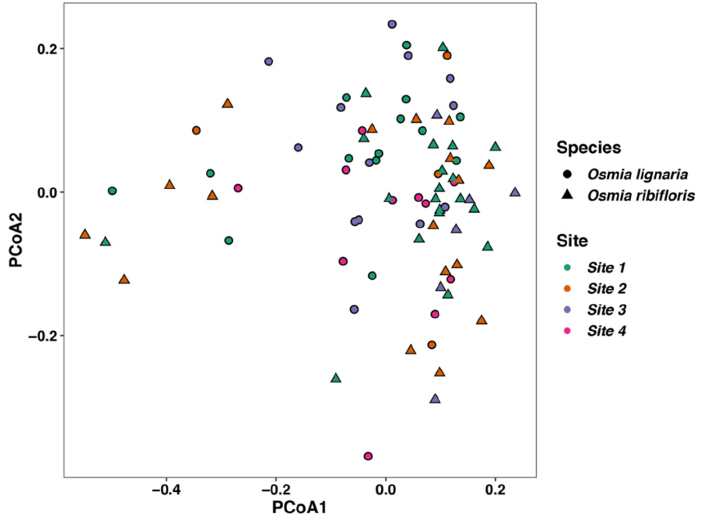
Figure 5. Principal components analysis (PCoA) ordination of the weighted UniFrac distances of microbial communities of both bee species ( Osmia lignaria and Osmia ribifloris ) and sampling site. There was a significant difference in the weighted UniFrac distances between bee species (F = 3.25, R 2 = 0.037, p = 0.004) and geographic location (F = 1.58, R 2 = 0.054, p = 0.03). Point shape denotes bee species, and color denotes site.